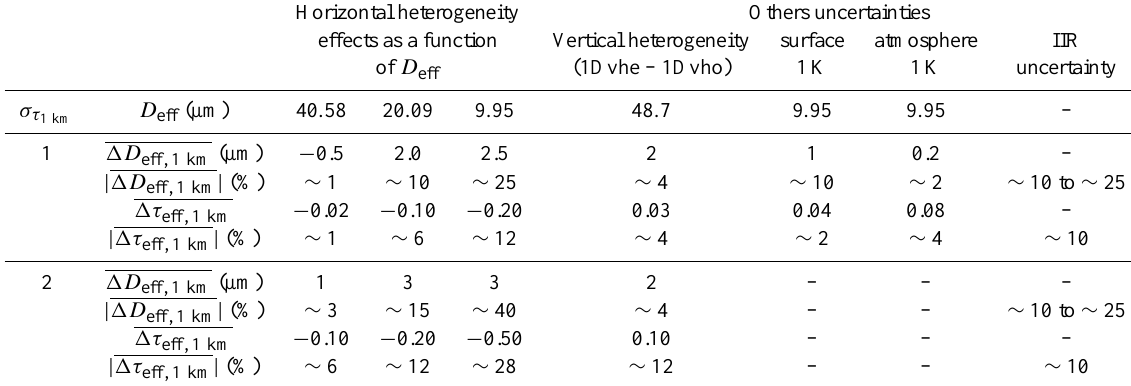
fer simulations. We can see that (cid:49)D 1-D